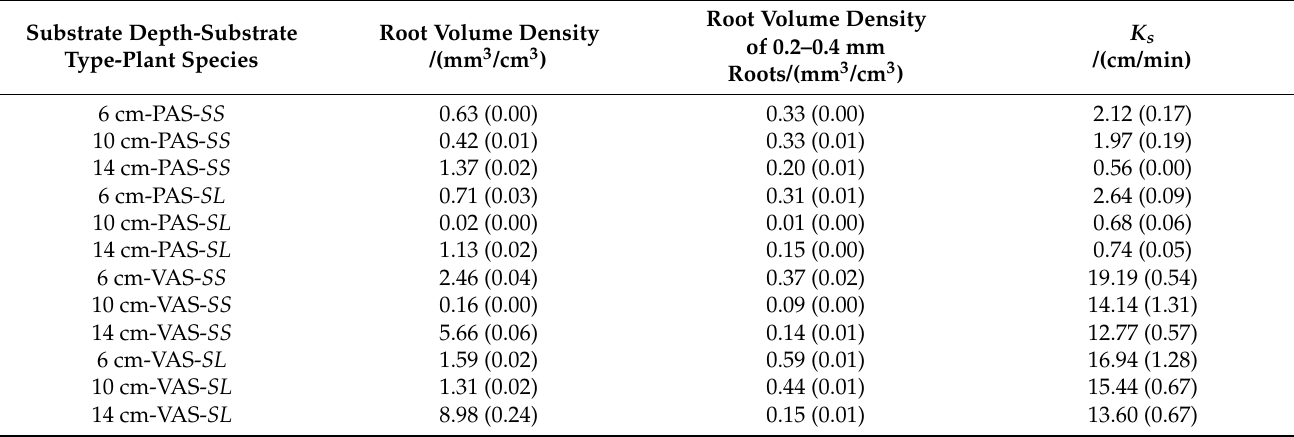
Table 2. Characteristics of plant roots and vegetated artificial substrates [mean